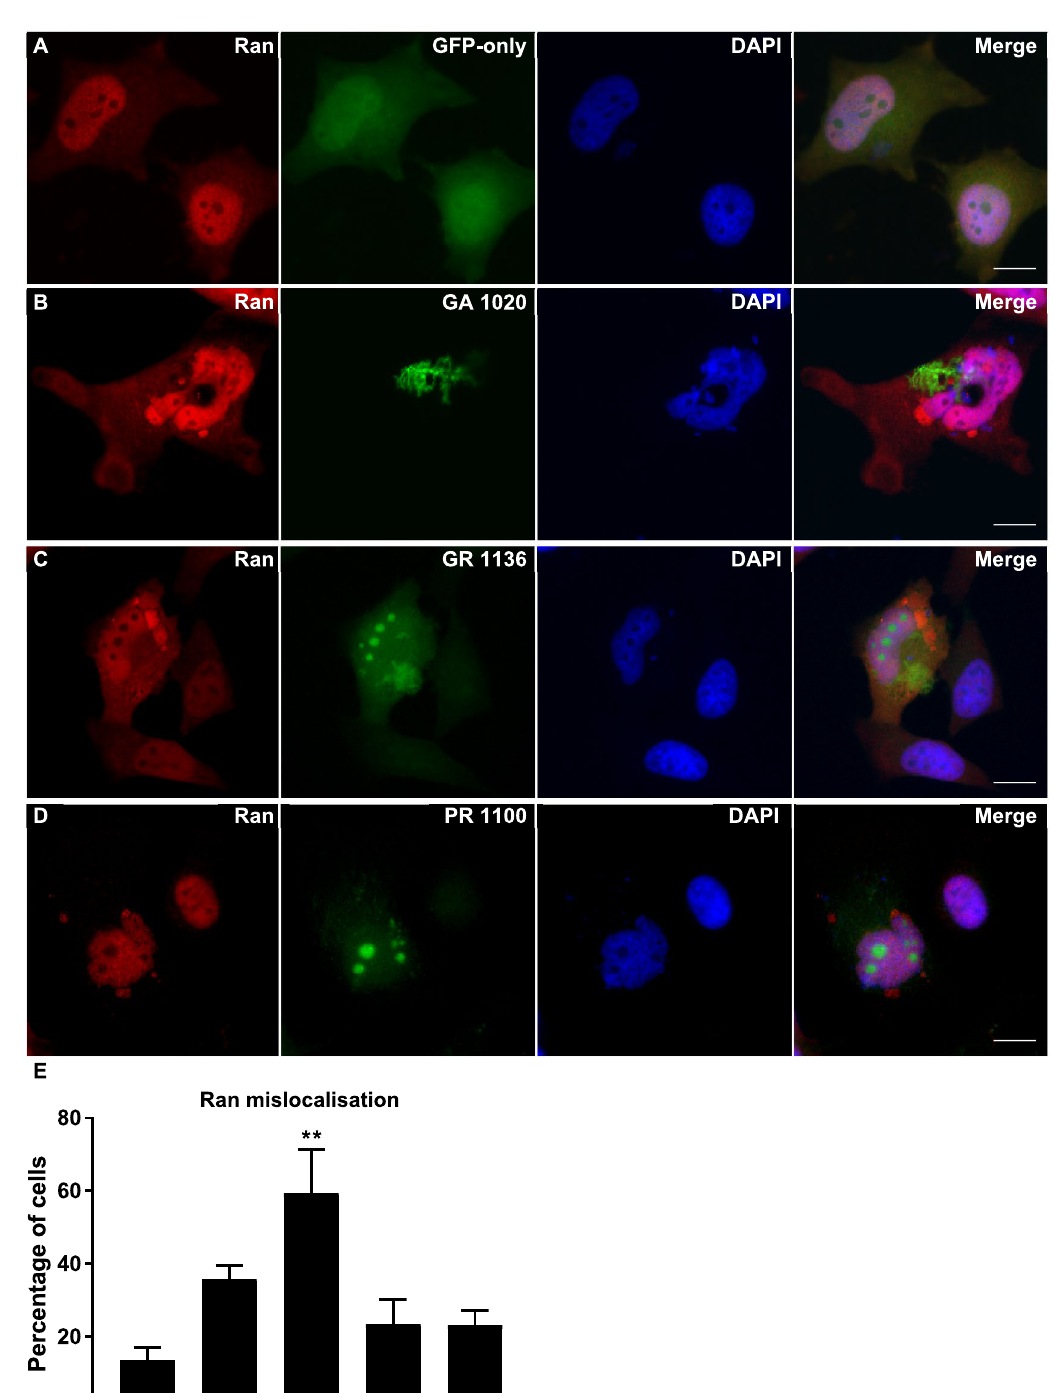
Figure 2. Ran was mislocalised to the cytoplasm in cells expressing DPRs. ( A – C ) HeLa cells transfected with GFP-tagged DPR constructs or empty pEGFP-N1 vector as a GFP-only control were fixed and stained 48 h post-transfection. Ran (red) is a predominately nuclear protein in GFP-only control cells ( A ) but frequently accumulated in the perinuclear region in cells expressing GA 1020 ( B ), GR 1136 ( C ) or PR 1100 ( D ). The percentage of cells with Ran mislocalisation was increased by expression of both GA ( P = 0.1226) and PR ( P = 0.0025), however this was only statistically significant for GR Scale bars indicate 15 μm. ( E ) Quantification of Ran staining intensity in the nucleus compared to the perinuclear region. Ran was considered to be mislocalised if less than 90% of staining was nuclear. n = 3, with a minimum of 30 cells analysed for each independent replicate. Data was analysed by one-way ANOVA with Dunnett’s multiple comparison test. Error bars indicate